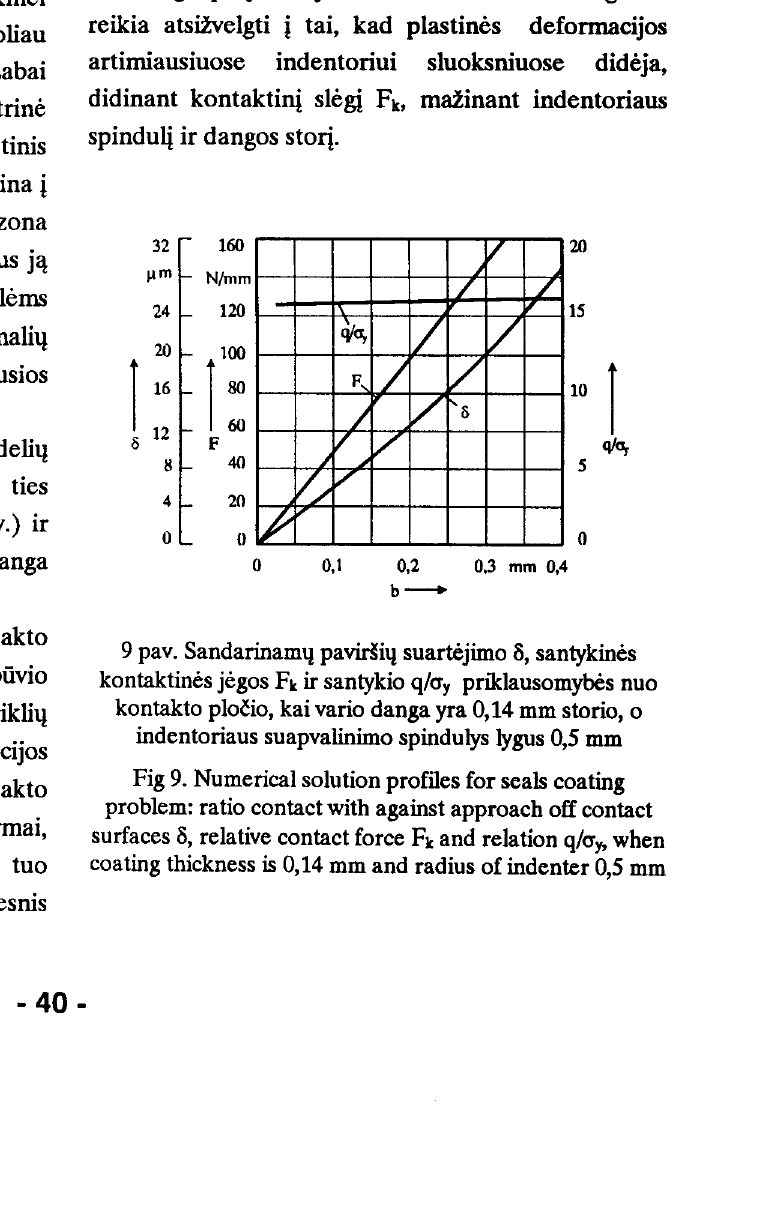
Fig 7. Numerical solution profiles for cantilever spring seal problem: ratio of relative seal radius against maximal stress intensity crx, pressure force F and contact pressure q1 5. Sandarikliq dangq deformavimas Toliau apfvelkime dangos deformavimo procesll.